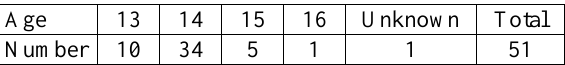
Table 1: Age of learners